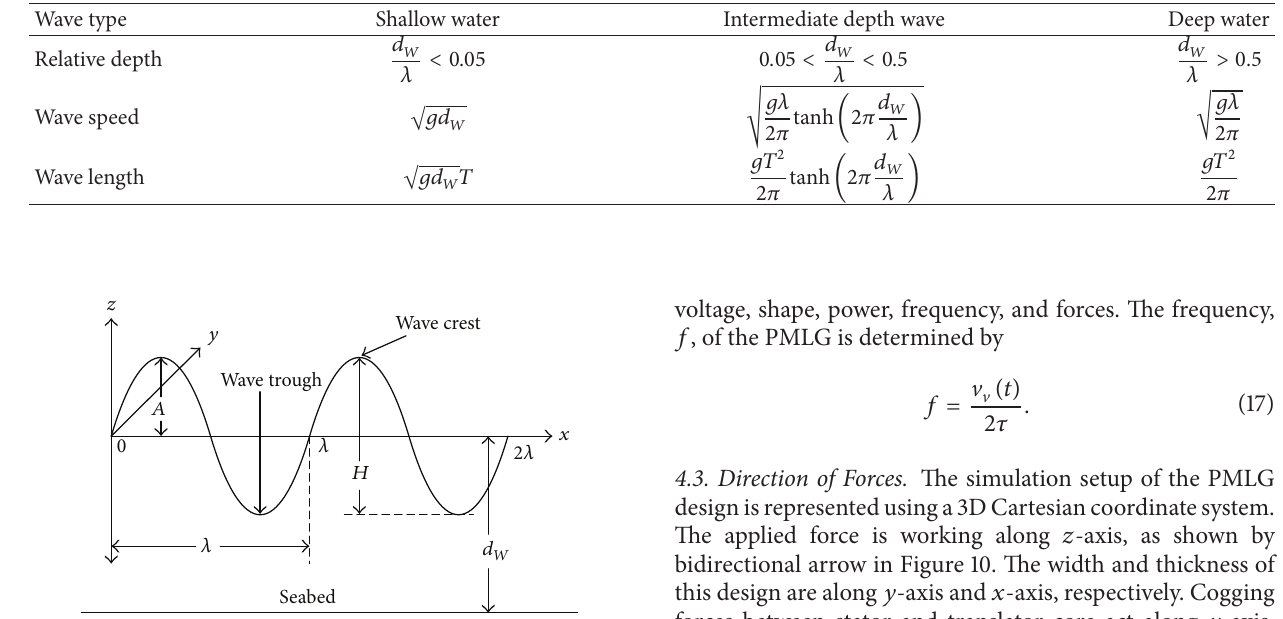
Table 1: Comparison of the oceanic wave parameters.